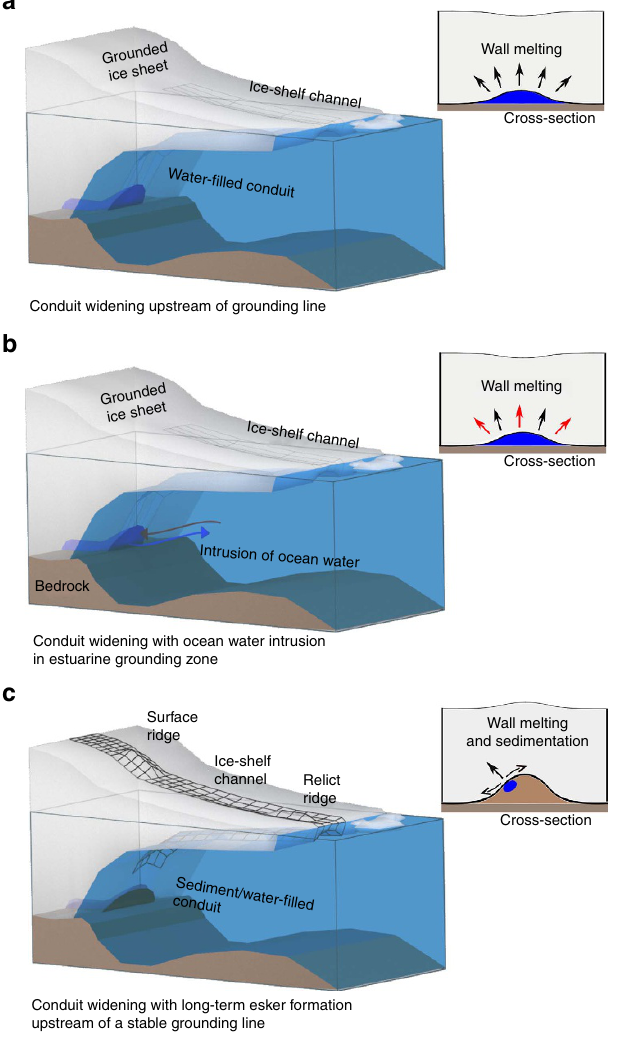
Figure 2 | Hypothesis for ice-shelf channel formation by subglacial water conduits. ( a ) Subglacial water conduits widen close to the grounding line due to diminishing closure rate forming an ice-shelf channel seawards. ( b ) Conduit widening is further amplified by intrusion of warmer ocean water, and ( c ) sedimentation forms an esker at the conduit’s portal as a consequence of conduit widening and decreasing water outflow speed. Ice flow over the esker causes a ridge to form at the surface, which may be preserved as a relict ridge in the ice shelf. This scenario accords best with our observations.